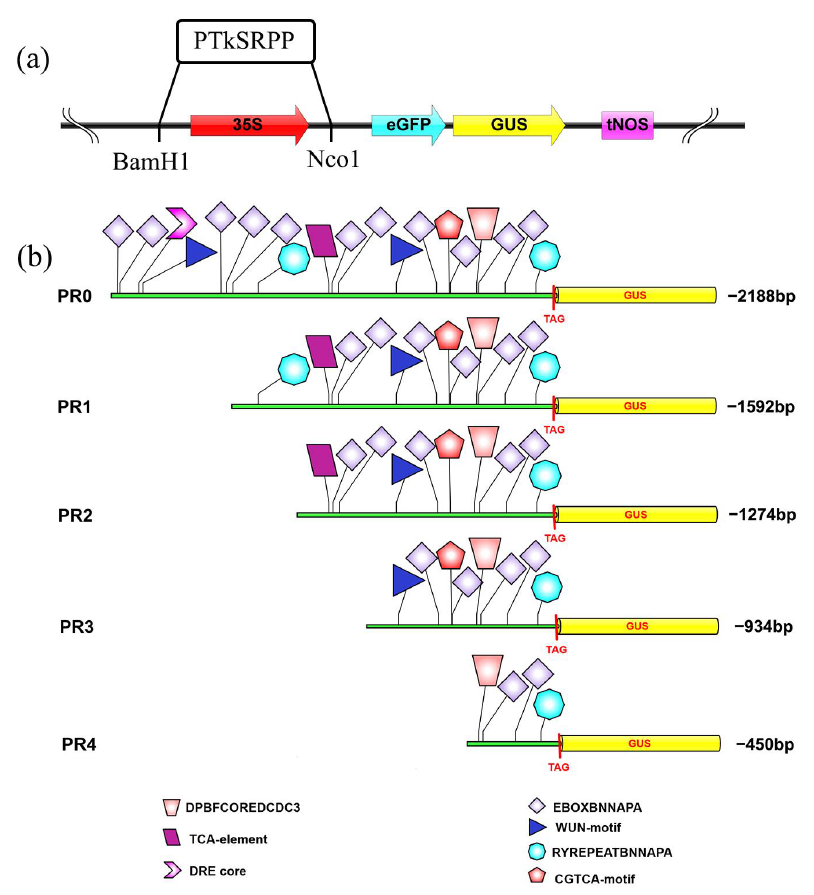
Figure 2. Schematic representation of the TkSRPP promoter regions controlling the expression of the GUS reporter gene. ( a ): Schematic drawing of the TkSRPP promoter expression cassette in the pCAMBIA1304:: GUS expression vector. ( b ): Diagram of the main cis -acting elements in the full-length TkSRPP promoter (PR0) and four promoter modules (PR1, PR2, PR3 and PR4). The cis -elements associated with phytohormone, and abiotic stresses are represented by different coloured boxes. To detect the activity of the PR0 promoter, the GUS histochemical staining was per- formed on tobacco leaves treated with Agrobacterium harboring PR0 to evaluate the stain- ing degree. The leaves of wild-type tobacco (negative control groups) were not stained while the tobacco leaf with 35S:: GUS (positive control groups) was obviously stained to appear as a large blue patch. The experiment showed that the stained degree of tobacco leaf with PR0:: GUS was deeper than that of the negative control groups but shallower than that of the 35S promoter (Figure 3), indicating that the transcriptional activity of the PR0 promoter was activated by upstream protein regulators in the tobacco leaf. Further- more, the GUS activity of other deletion promoters (PR1/PR2/PR3/PR4) was also analyzed